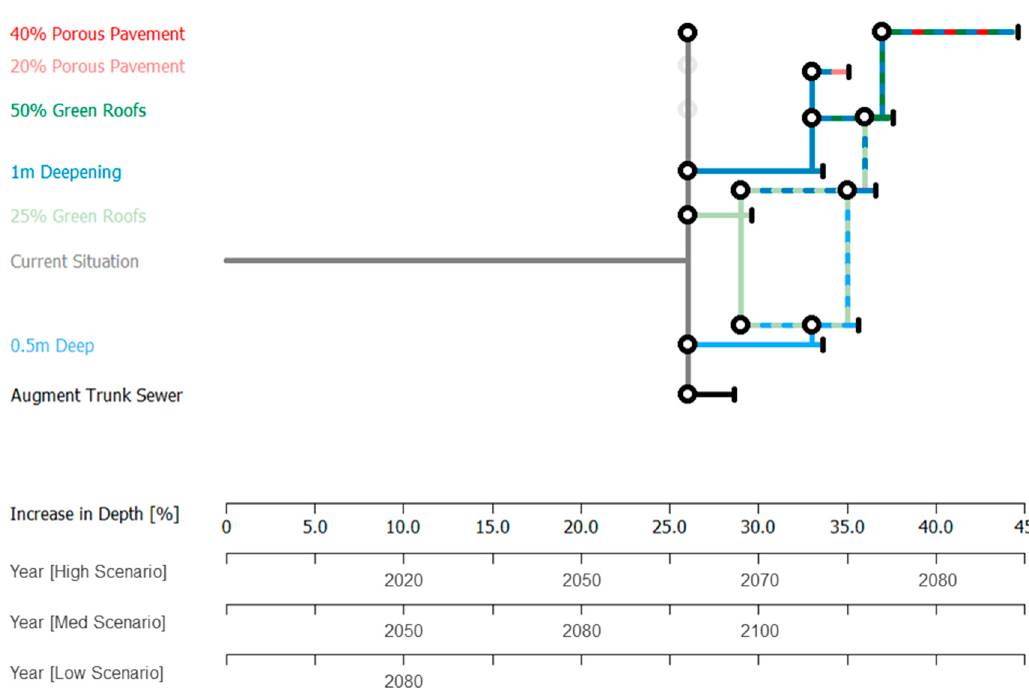
Figure 1. Adaptation Pathways for increases in depth. Adaptation Pathways are read from left to right. Adaptations are listed on the left. The current situation represents system performance without any adaptations. When a strategy reaches its ATP, potential suitable adaptations are suggested. Multi-coloured lines indicate that multiple adaptations are present.